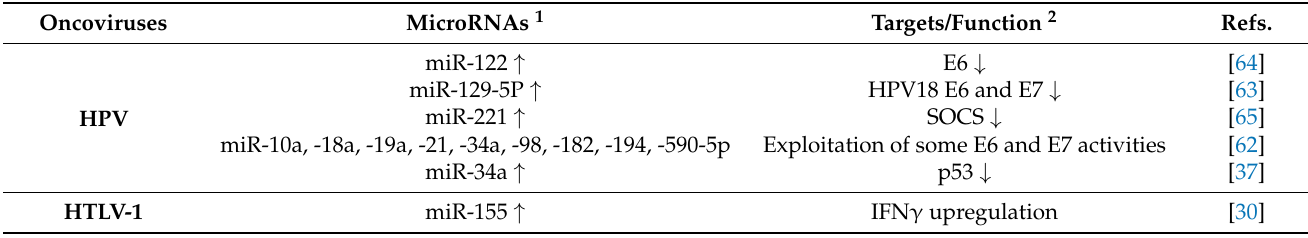
Table 1. MicroRNAs linked to IFNs response in virus-induced